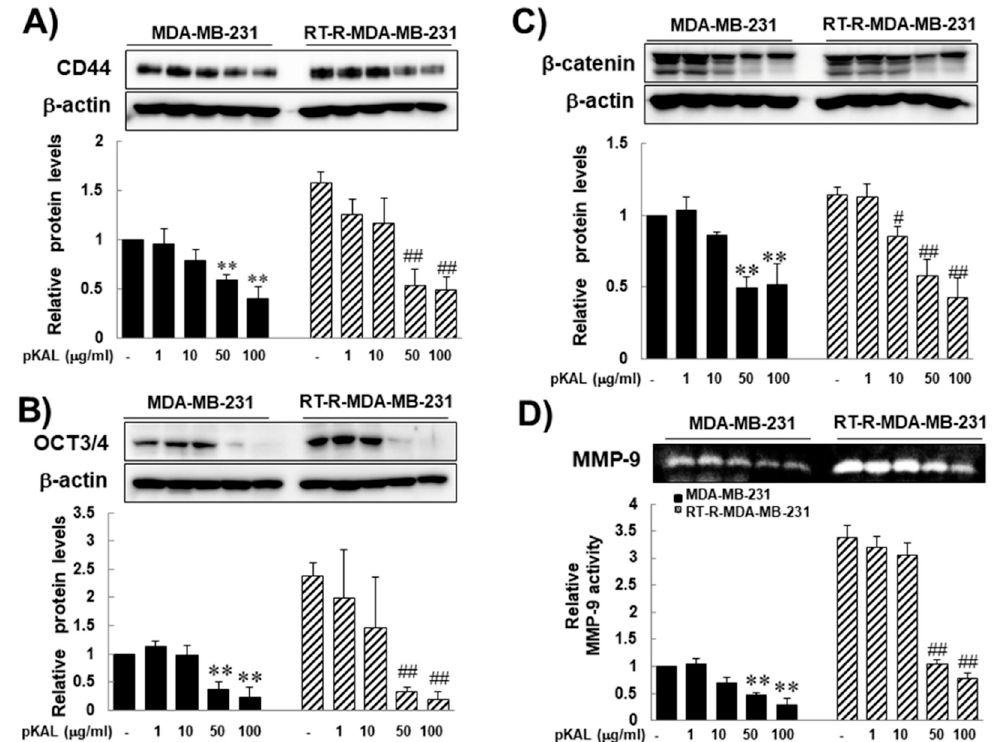
Figure 2. Inhibitory e ff ects of Artemisia annua L. (pKAL) on the expression of stem cell markers (CD44 and Oct 3 / 4), β -catenin and the activity of MMP-9 in both parental and RT-R-MDA-MB-231 cells. The cells were treated with the indicated concentrations of pKAL for 24 h. The expressions of CD44 ( A ), Oct3 / 4 ( B ) and β -catenin ( C ) were measured from the cell lysates by Western blot analysis. ( D ) The activity of MMP-9 was examined by gelatin zymography. The band density was quantified by densitometry, and the values are expressed as the means ± SEM from three independent determinations (** p < 0.01 vs. control for parental MDA-MB-231 cells, # p < 0.05 vs. control for RT-R-MDA-MB-231 cells, and ## p < 0.01 vs. control for RT-R-MDA-MB-231 cells).